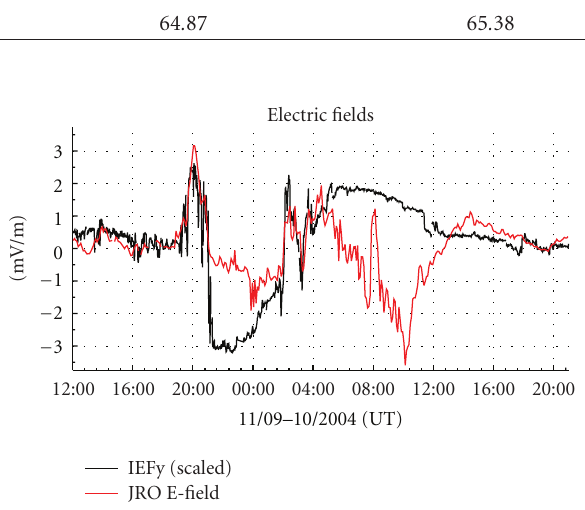
Figure 2: The black-line plot is the y -component of the electric field in the Earth’s frame of rest delayed by the transit time of the solar wind to the front of the magnetosphere divided by ten for a 33h period on November 2004. The red-line plot is the zonal component of the electric field in the equatorial ionosphere. (After [8]. Reproduced with permission of the European Geoscience